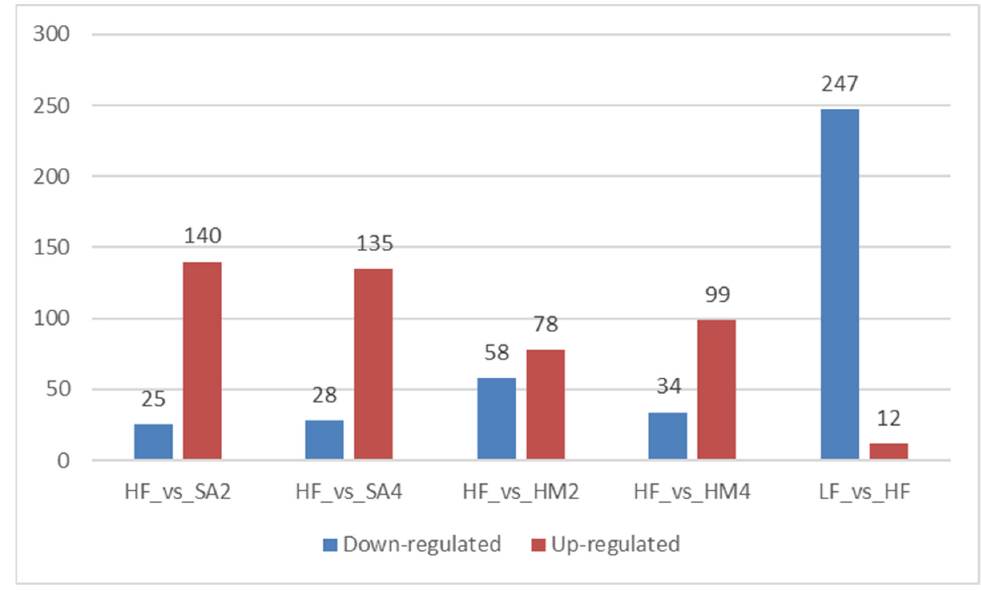
Figure 4. The abscissa represents the comparison of the HF group with each group of metabolites, and the ordinate represents the count of significantly changed metabolites; the red part indicates up-regulating and the blue part indicates down-regulating.